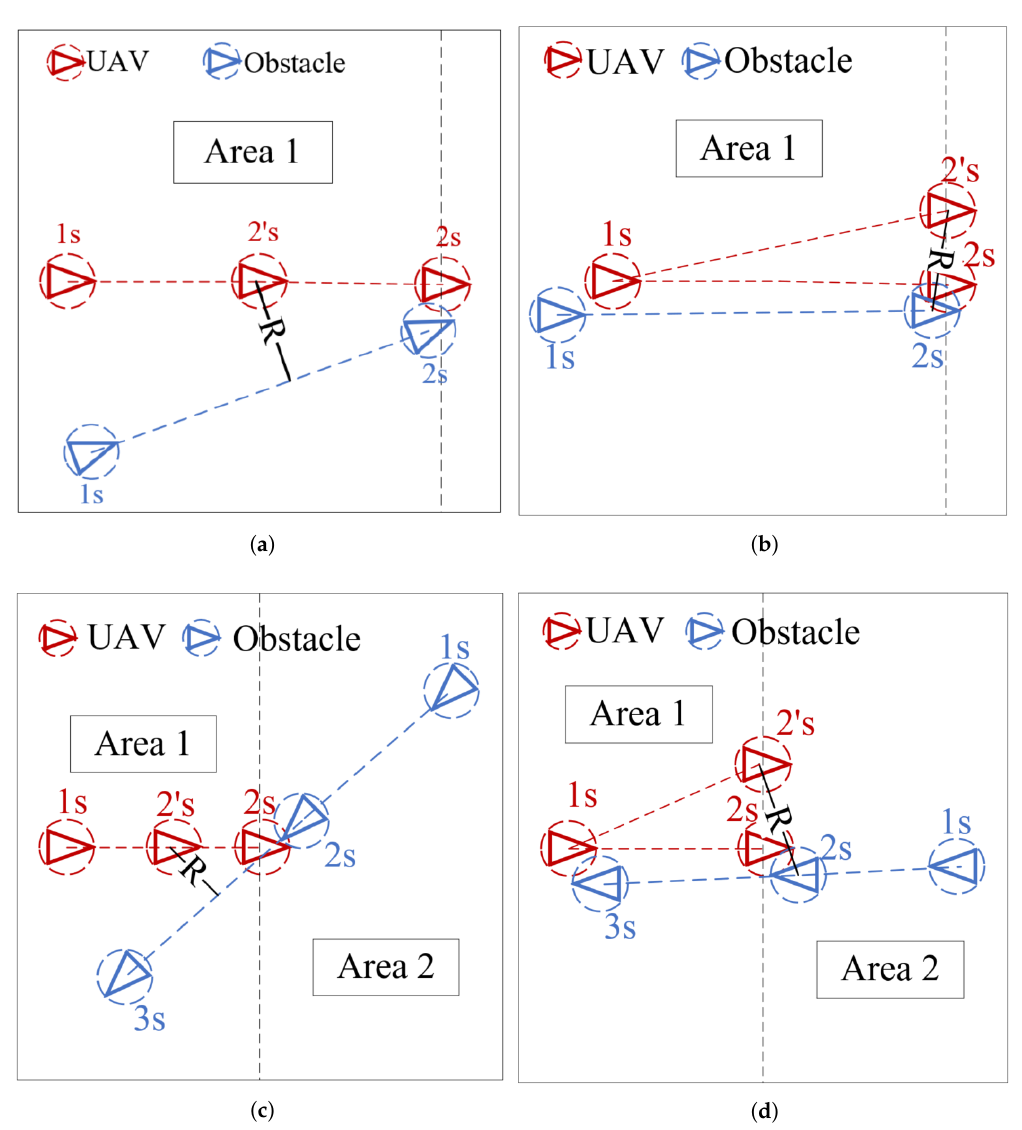
Figure 7. R refers to the distance recorded between the UAV and the obstacle in every second. ( a , b ) show the obstacle avoidance of UAV when the obstacle is co-directional; ( c , d ) show the obstacle avoidance of UAV when the obstacle is